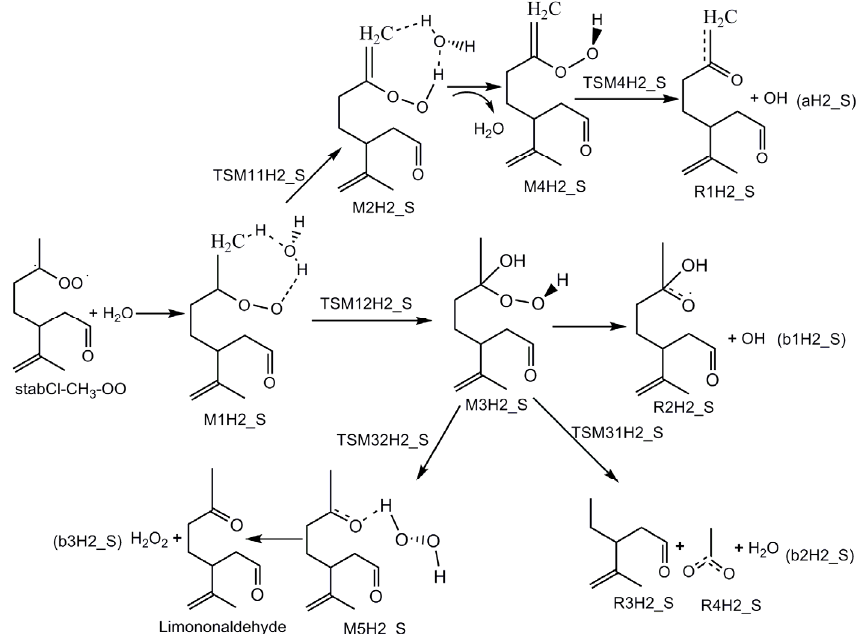
O and stabCI-OO arising from 2